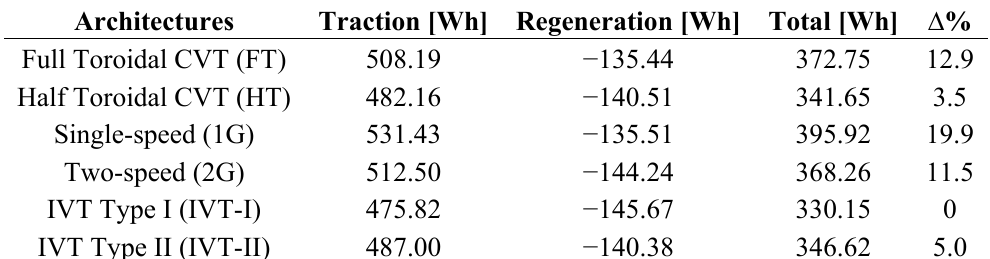
Table 5. Energy consumption in Wh along the